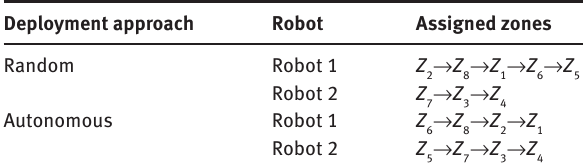
Table 3: Assigned Areas for the Scenario with Two Robots.